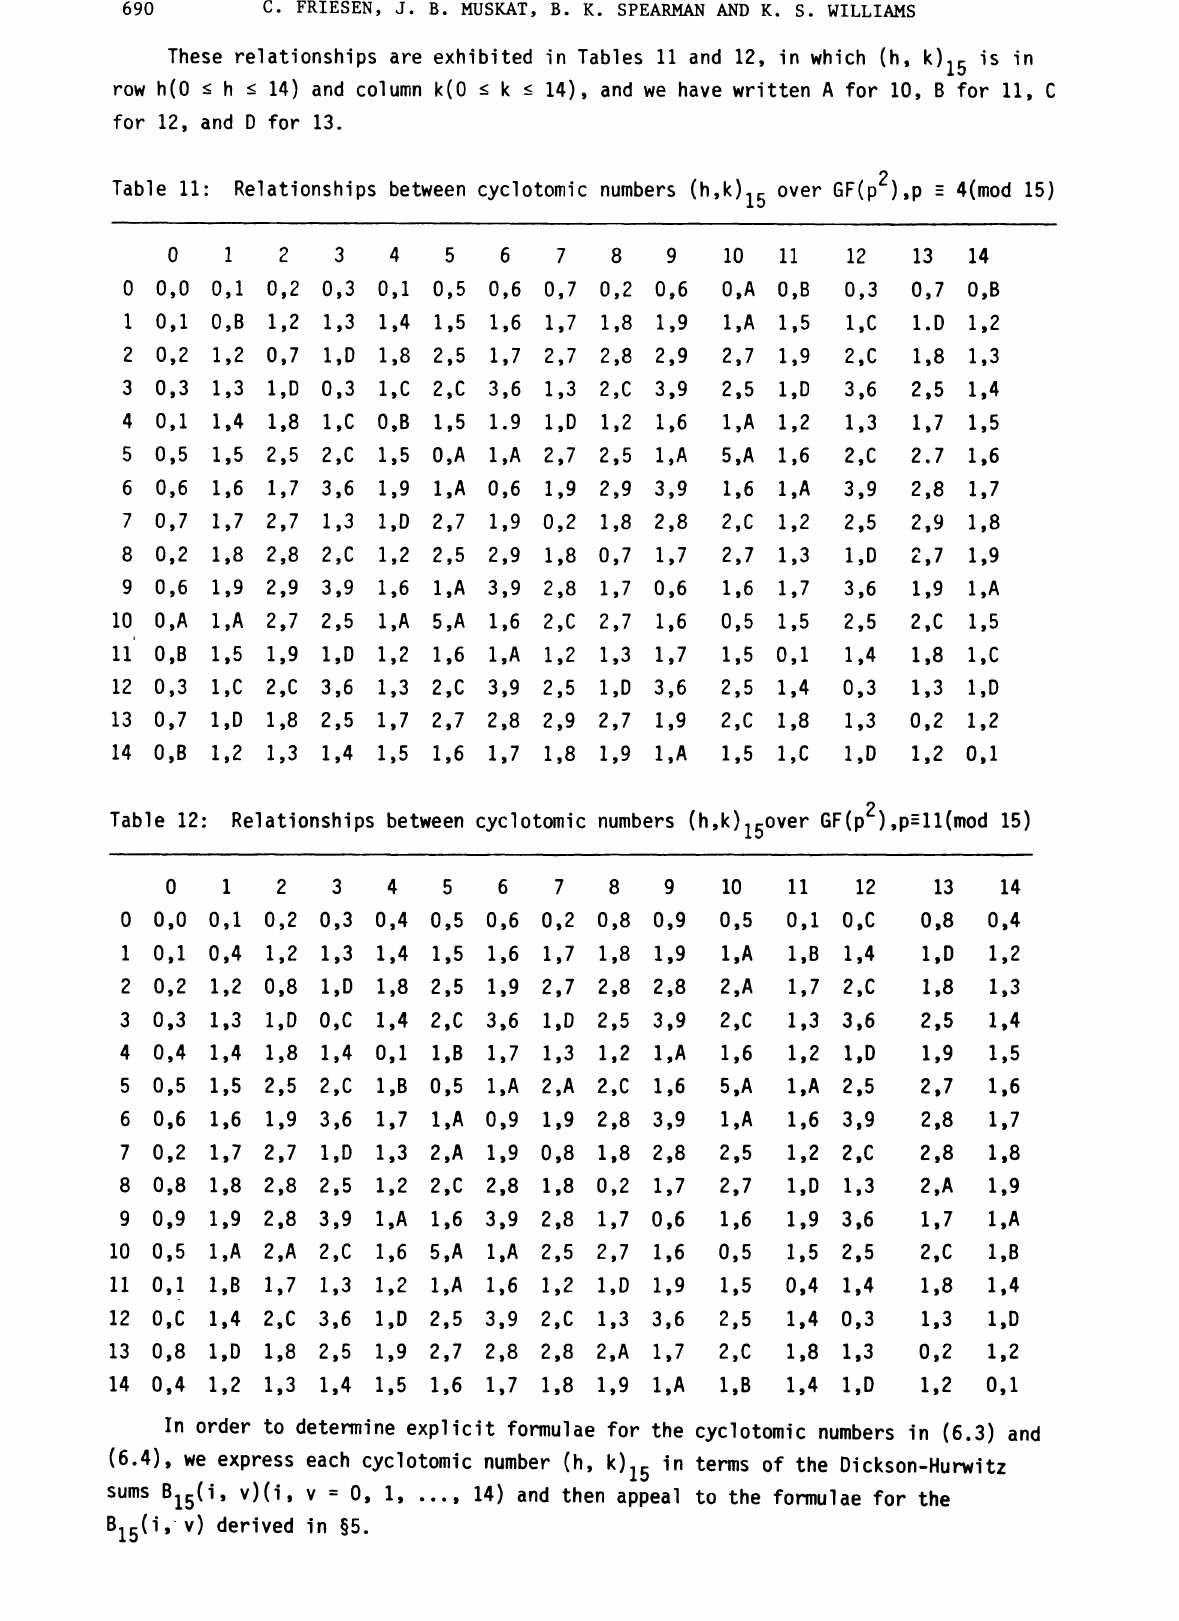
Relationships between cyclotomic numbers (h,k)15 over